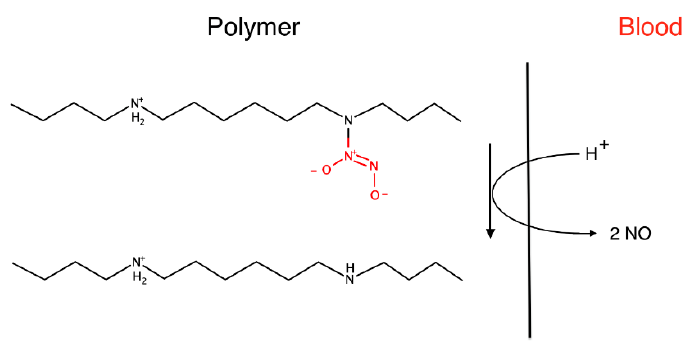
Figure 11. Mechanism of NO-release from dibutylhexyldiamine diazeniumdiolate (DBHD/N 2 O 2 ).